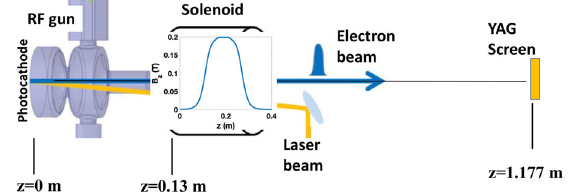
FIG. 7. The solenoid is installed at z ¼ 0 . 13 m from the photocathode. The solenoid configuration has the four coils with same fields. After the solenoid and a drift space a YAG:Ce screen is placed perpendicular to the electron beam at z ¼ 1 . 177 m (image not in scale).